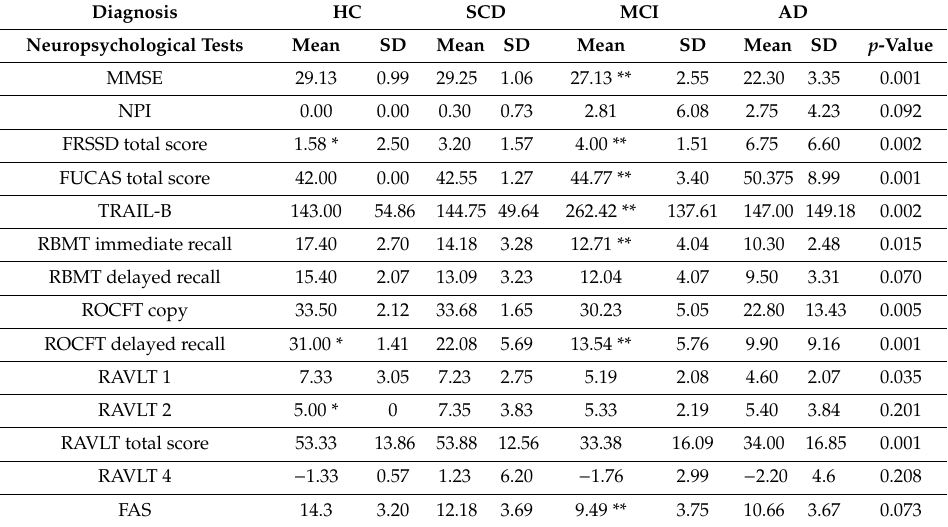
Table 2. The table shows the mean ± SD (standard deviation) of neuropsychological assessments of the participants (size in groups: HC = 22, SCD = 20, MCI = 30, AD = 20). The last column of the table shows the p -values of one-way